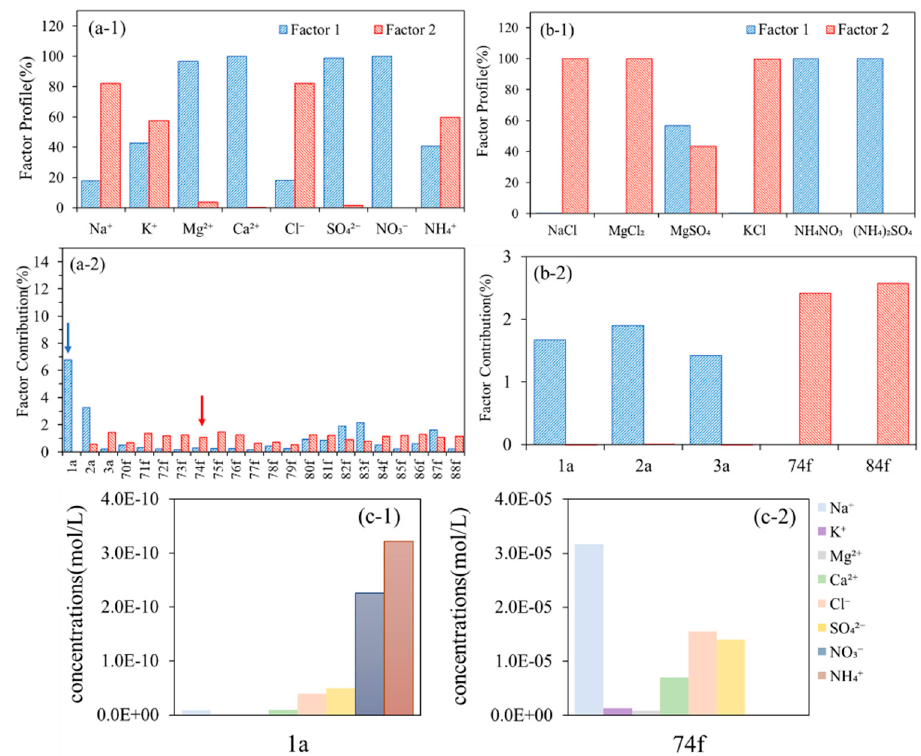
Figure 10. ( a-1 , a-2 ) PMF solution of ionic concentrations. ( b-1 , b-2 ) PMF solution of calculated DRHs. ( c-1 , c-2 ) Ionic Figure 10. ( a ) PMF solution of ionic concentrations. ( b ) PMF solution of calculated DRHs. ( c ) Ionic compositions of typical cases for the two factors. compositions of typical cases for the two factors.